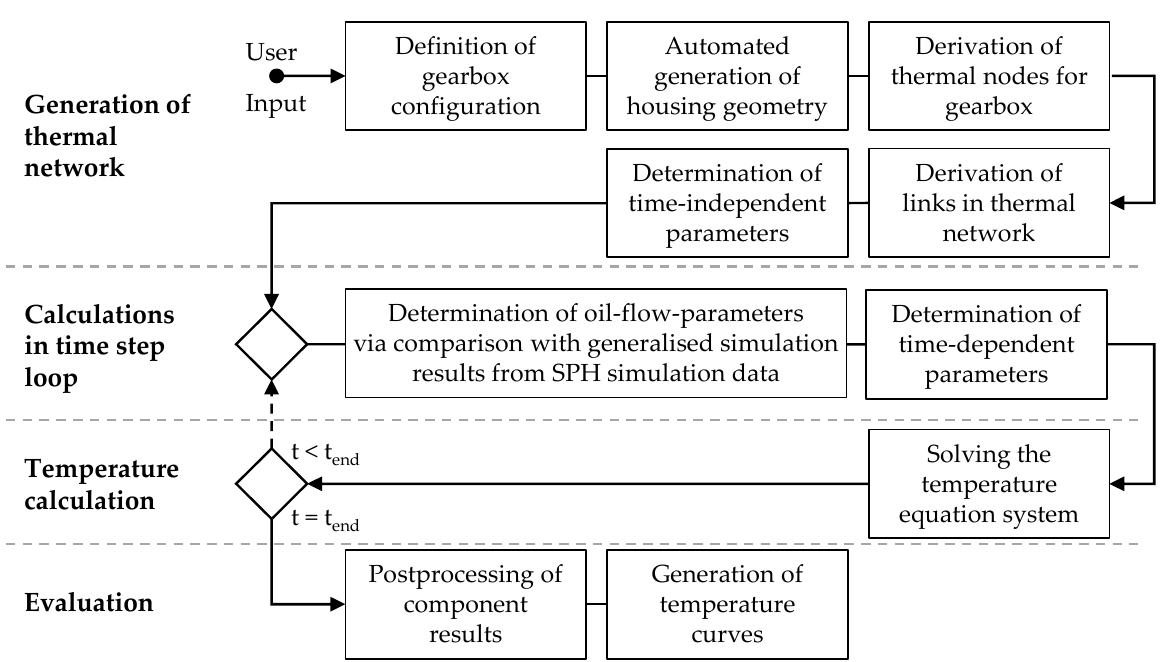
Figure 7. Stepwise process of model generation and calculation of the thermal network.